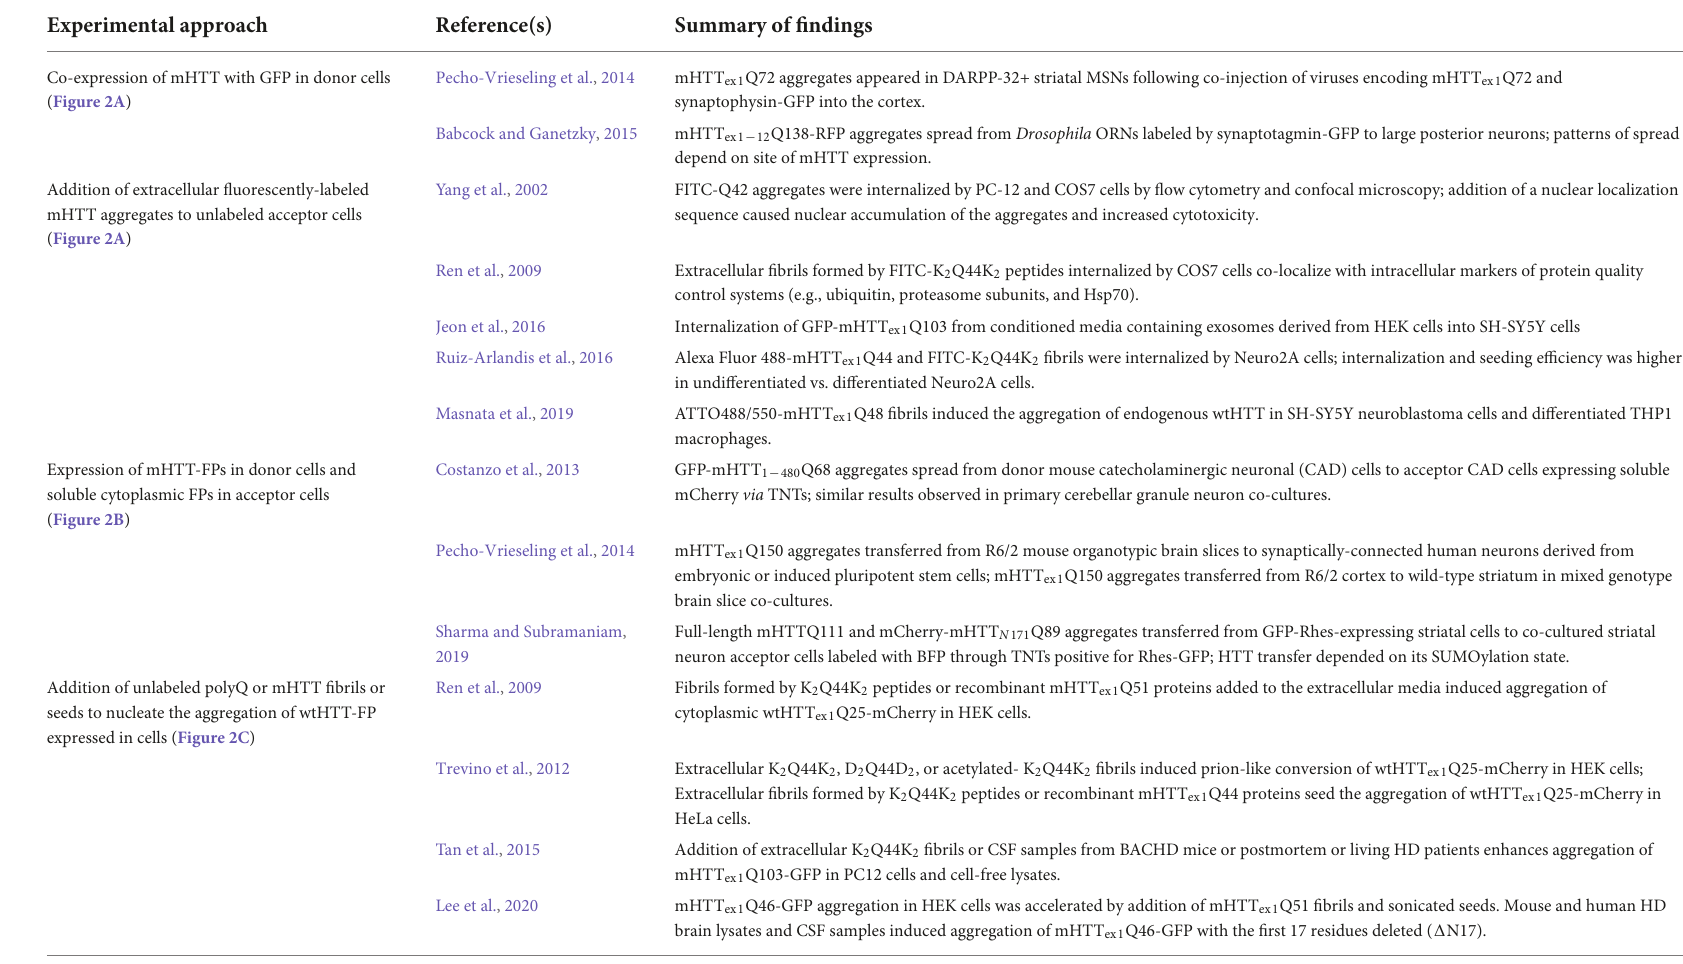
TABLE 1 Experimental approaches to study prion-like properties of